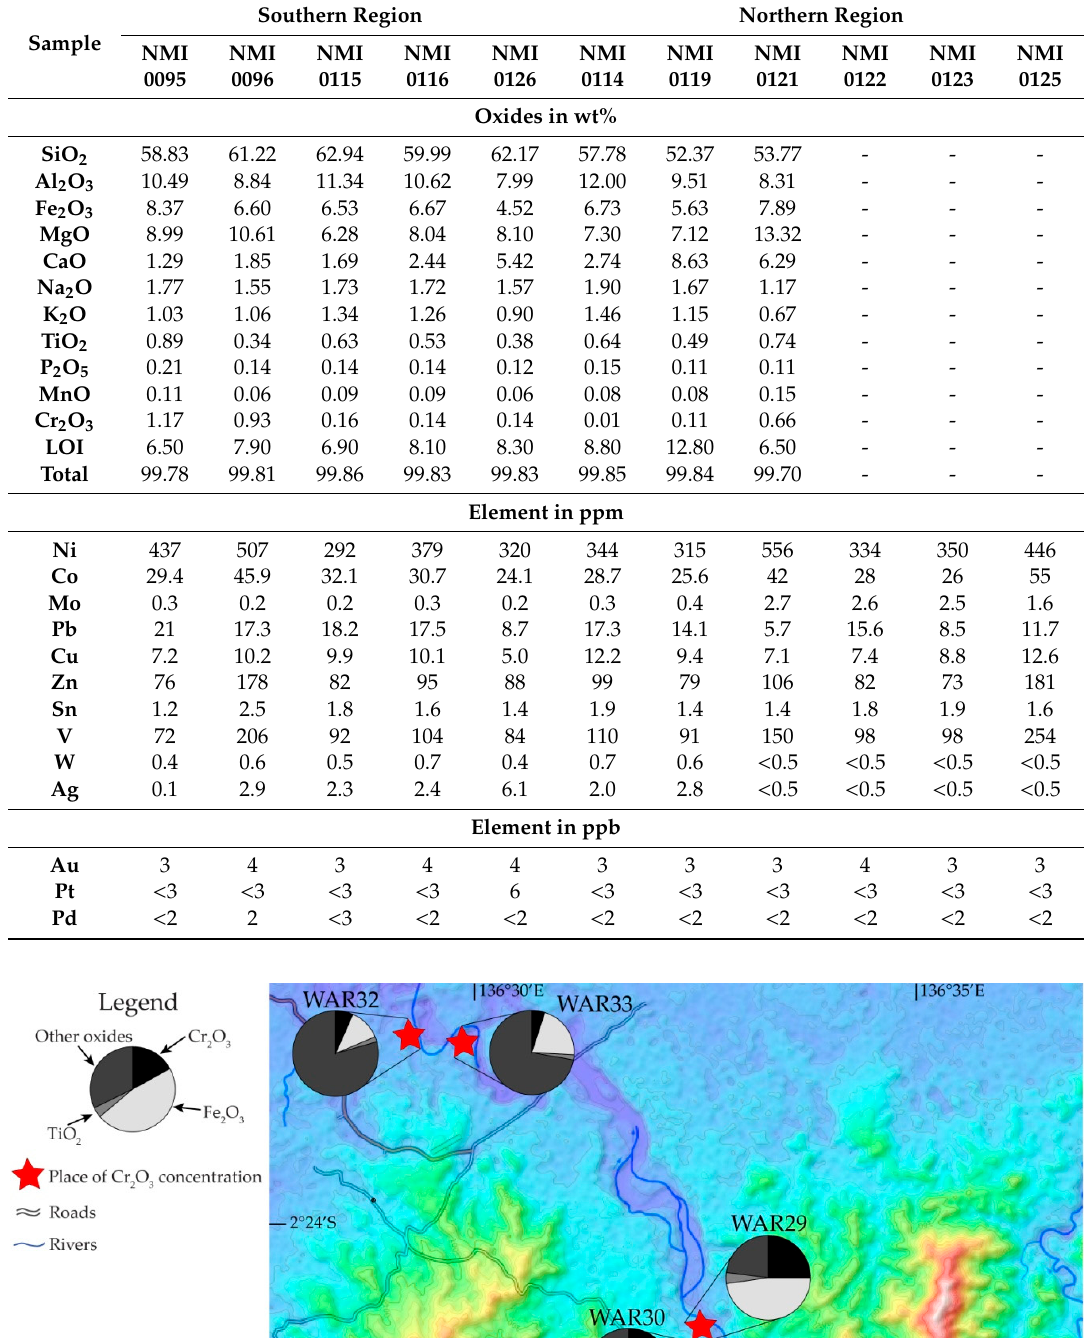
Table 3. Chemical composition of beach sediment samples.